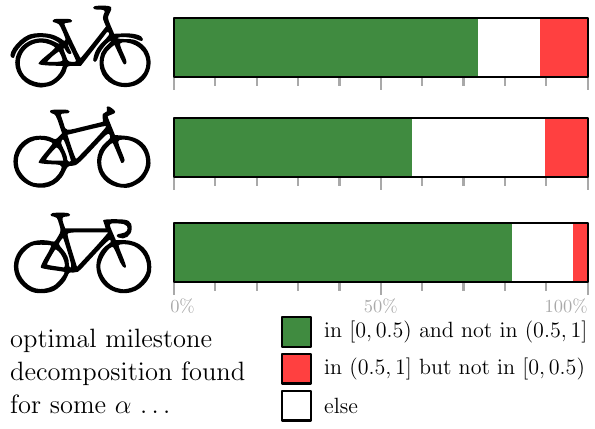
Figure 7. Overview of the distribution of minimal decompositions for cycling (top), mountainbiking (center), and racingbiking (bottom). The green bar indicates the share of trajectories that have minimal decompositions only for α values less than or equal to 0 . 5 ; the red bar represents the trajectories with minimal decompositions only for α values greater than or equal to 0 . 5 . Trajectories with an optimal decomposition only for α = 0 . 5 as well as all remaining trajectories are represented by the white bar.